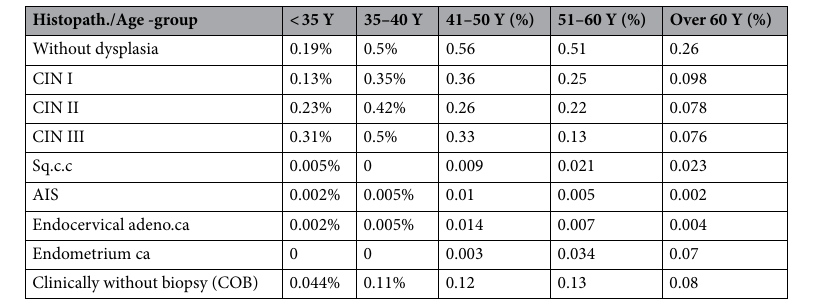
Table 1. The histopathological results distributed in the different age-groups.